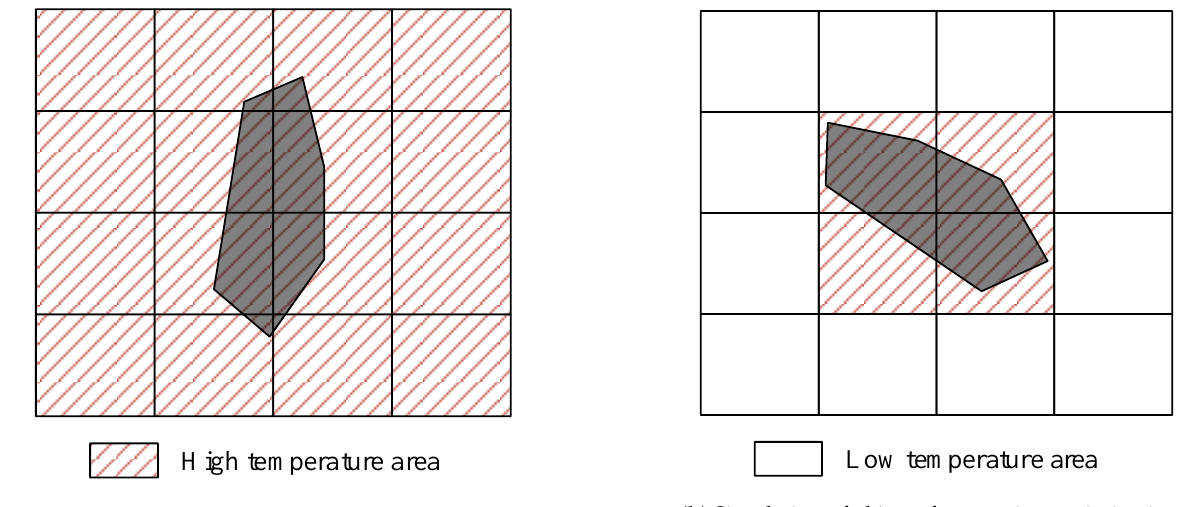
Figure 11. Object rotation for power consumption